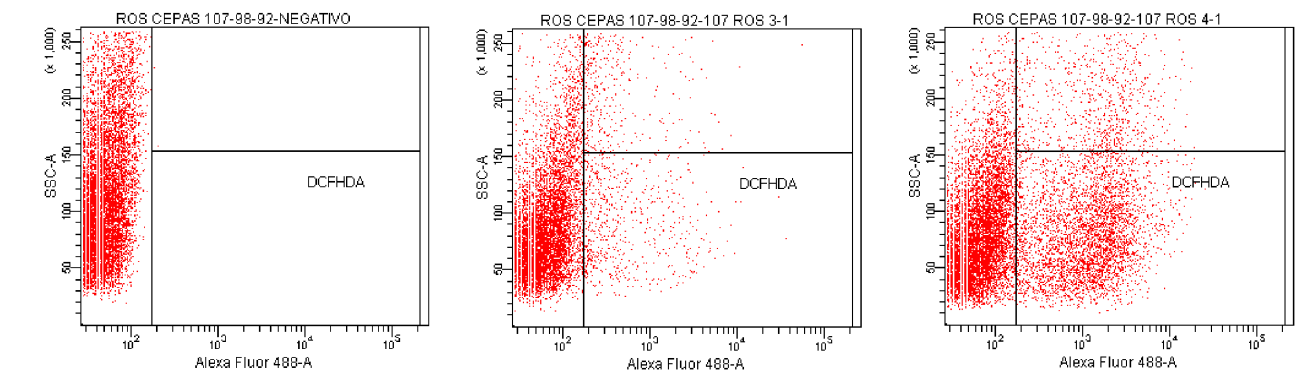
Figure 12. DCFH-DA fluorescence emitted by C. tropicalis yeasts untreated ( a ), treated with H 2 O 2 ( b ) and treated with ISO ( c ).